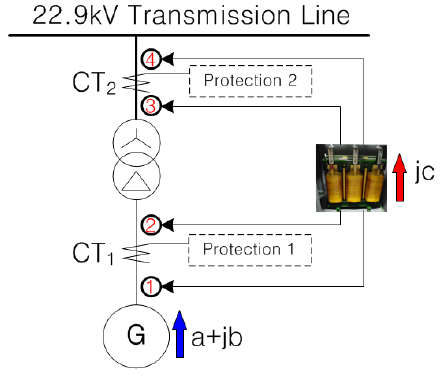
Figure 3. Candidate for location of the reactor. Table 1. CT currents according to locations of the